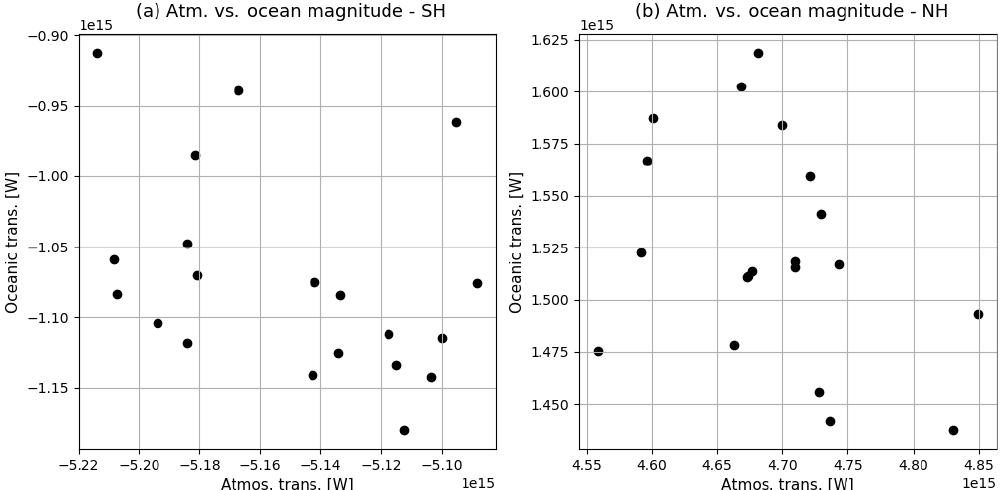
Figure 3. Scatter plots of 20-year pre-industrial CanESM2 annual mean atmospheric vs. oceanic peak magnitudes (W) in the SH (a) and the NH (b) .